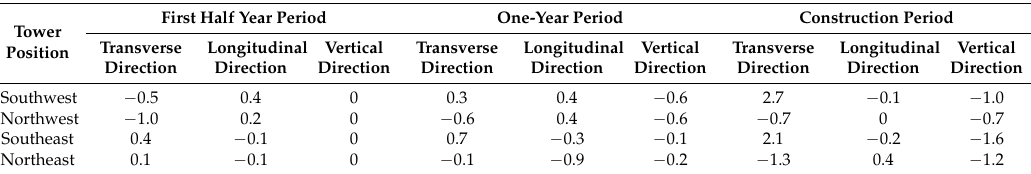
Table 2. Measured tower deformation (cm).